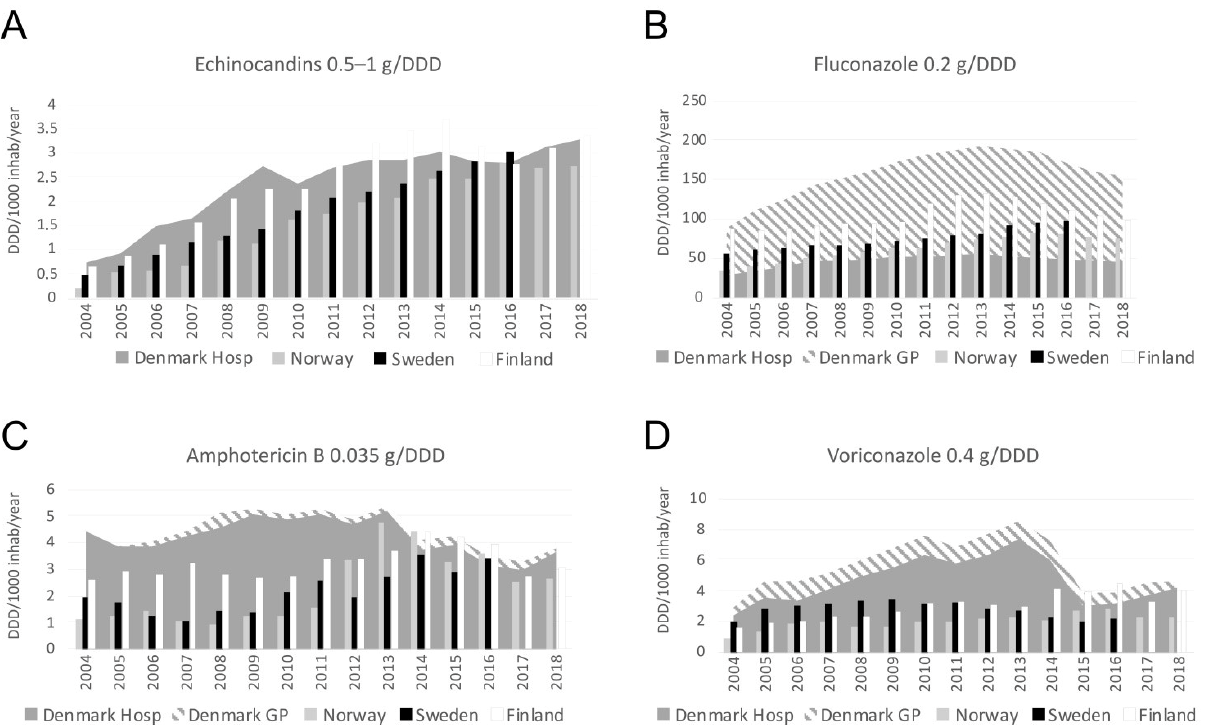
Figure 5. Annual consumption of selected antifungal compounds (( A ) Echinocandins, ( B ) Fluconazole, ( C ) Amphotericin B, ( D ) voriconazole) shown in DDDs per 1000 inhabitants per year in 2004 to 2018. For Denmark the usage is divided into hospital use (Hosp) and general practitioner use (GP). Data from 2004 to 2015 were also shown in the surveillance by Astvad et al. [10].